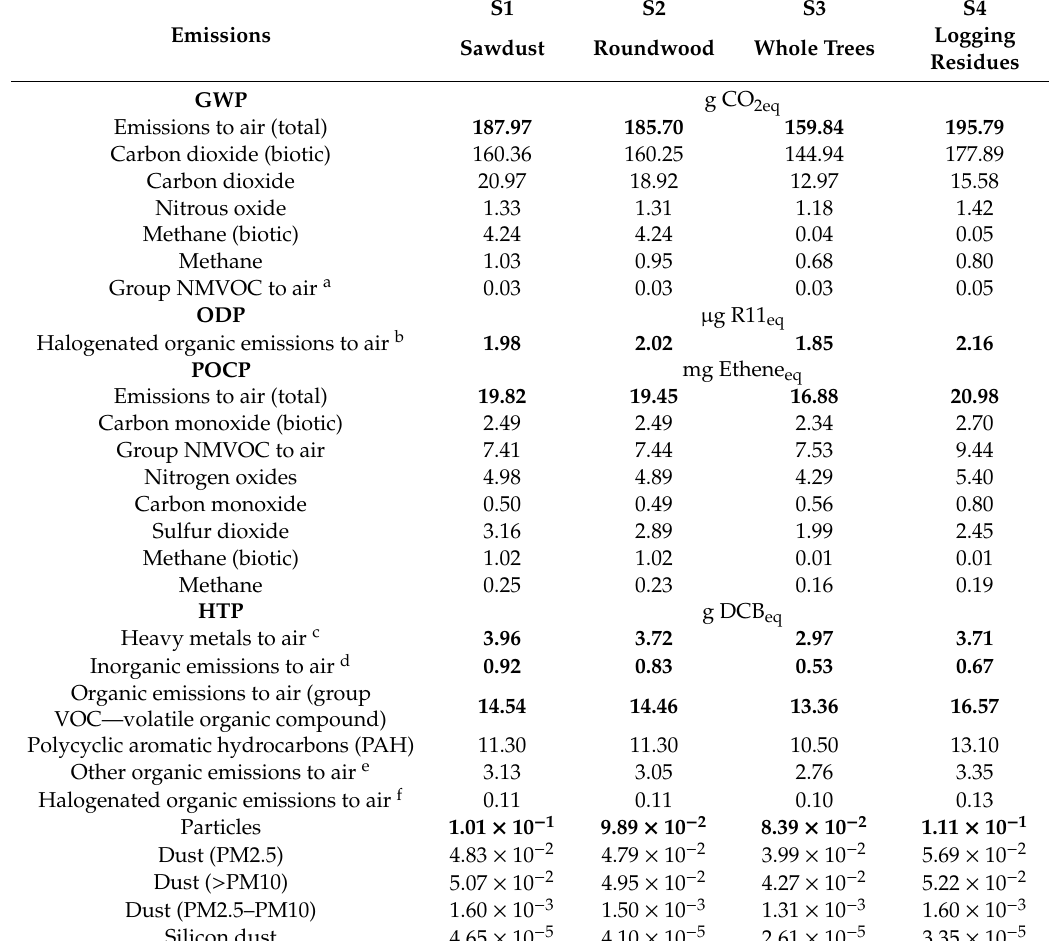
Table 3. Specific emission quantities grouped per impact category (GWP: Global Warming Potential, ODP: Ozone Depletion Potential, POCP: Photochemical Ozone Creation Potential and HTP: Human Toxicity Potential) and systems assessed (S1: pellets from sawmill sawdust; S2: pellets from roundwood; S3: pellets from whole trees, S4: pellets from logging residues) for the production of 1 MJ of thermal energy by burning wood pellets delivered to the final